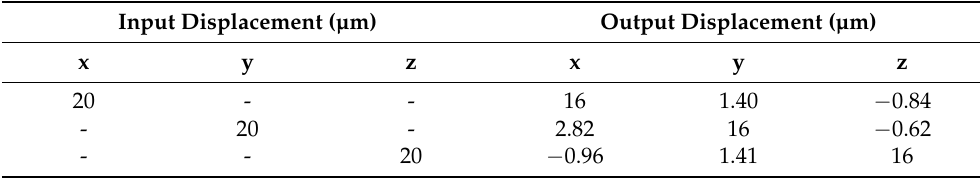
Table 3. Performance of the proposed triaxial compliant